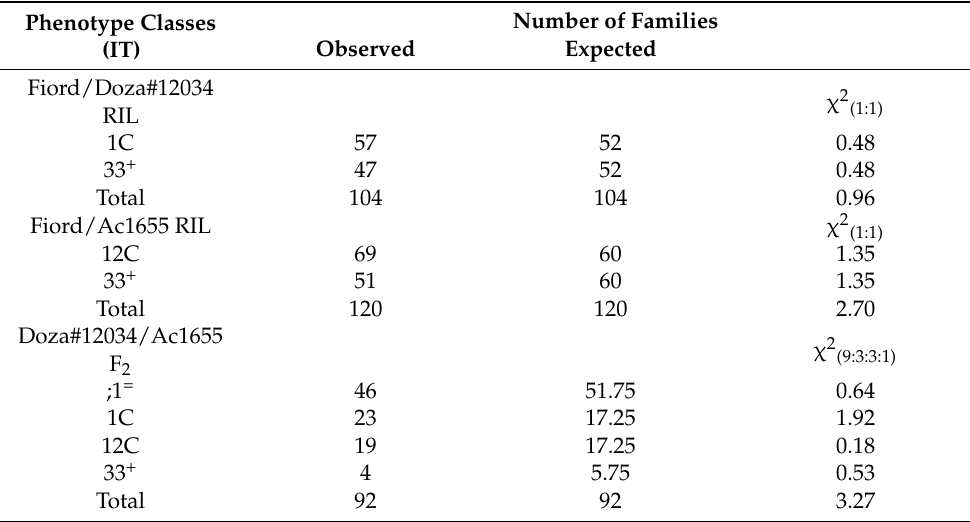
Table value of χ 2 at p = 0.05, 1 df = 3.84, 3 df =